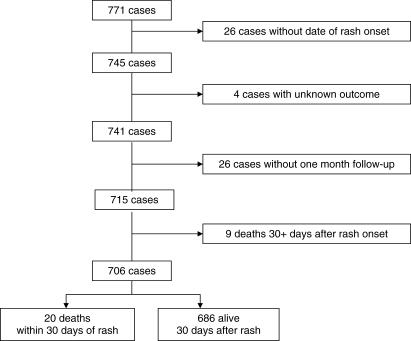
Flow Diagram of Measles Cases Included in the Study, Moursal, N'Djamena, Chad (2004–2005)